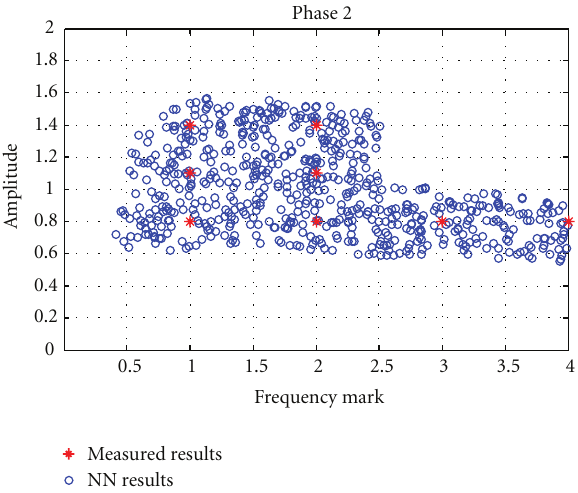
Figure 6: Results of neural network training for first stage. Figure 7: Results of neural network training for second